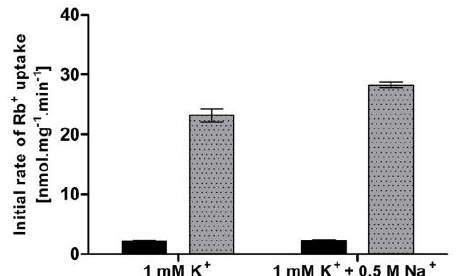
Figure 2. Effect of high external Na + concentration on Trk1-mediated Rb + uptake. BYT12 [pCScTRK1] cells were grown overnight as described in Section 2, and then incubated in a YNB-F supplemented with either 1 mM K + or 1 mM K + and 0.5 M Na + for 1 h. Initial rates of 50 µM (black columns) and 5 mM (grey columns) Rb + uptake were measured, as described in Section 2.